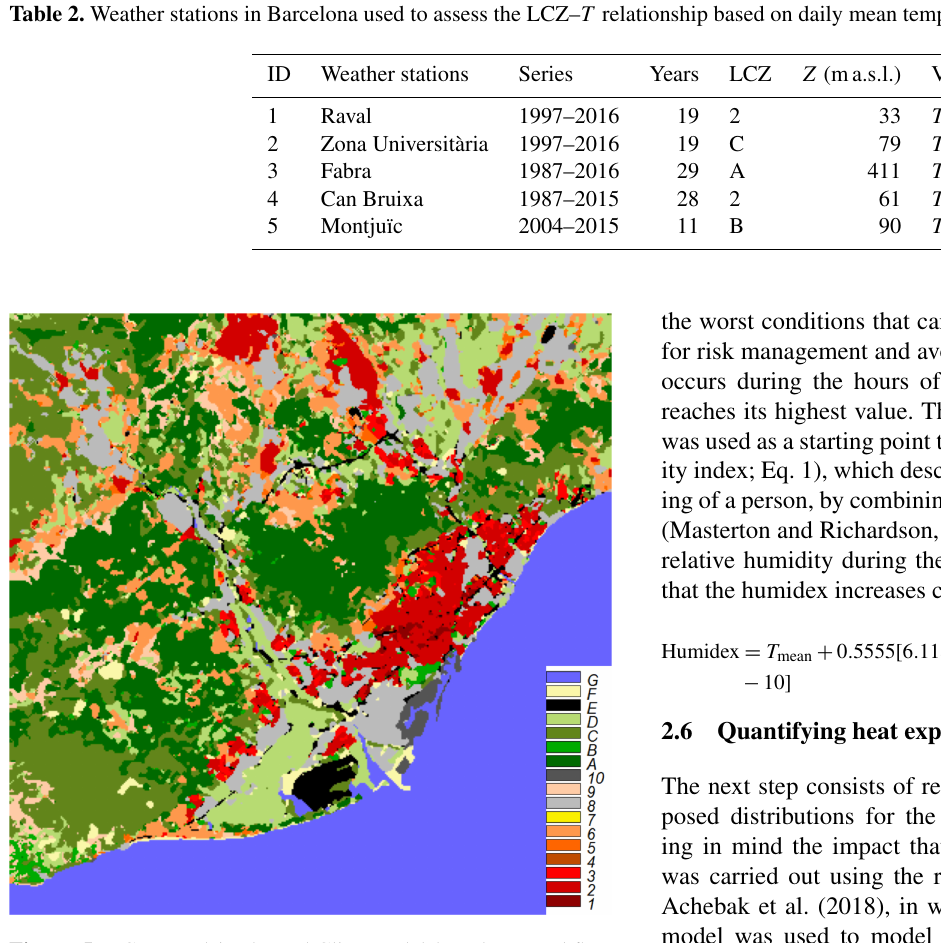
Figure 5. LCZs used in the UrbClim model based on workflow shown in Fig.